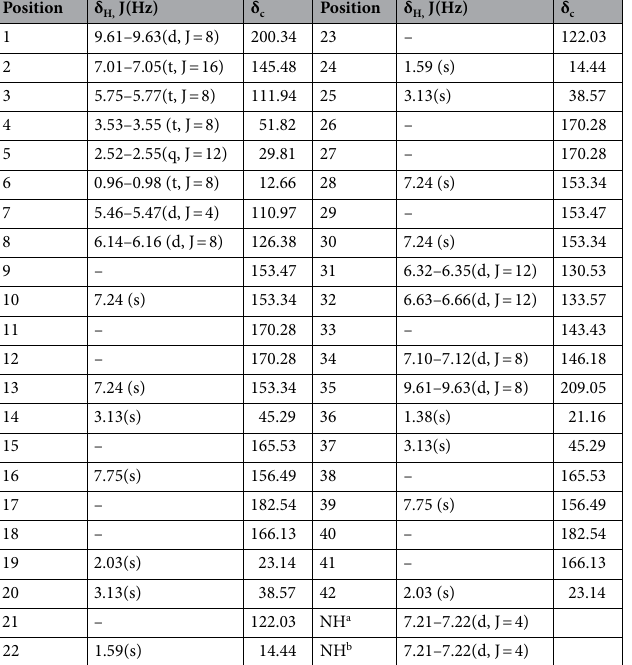
Table 2.. 1 H and 13 C NMR spectral data of SM02 in CDCl 3 .